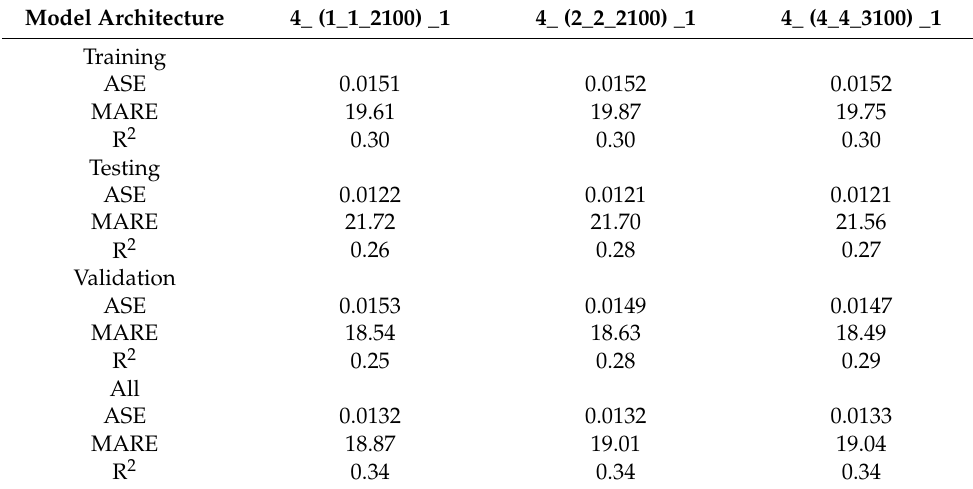
Table 3. Statistical accuracy measures of model for predicting seismic wave velocity using field data, with